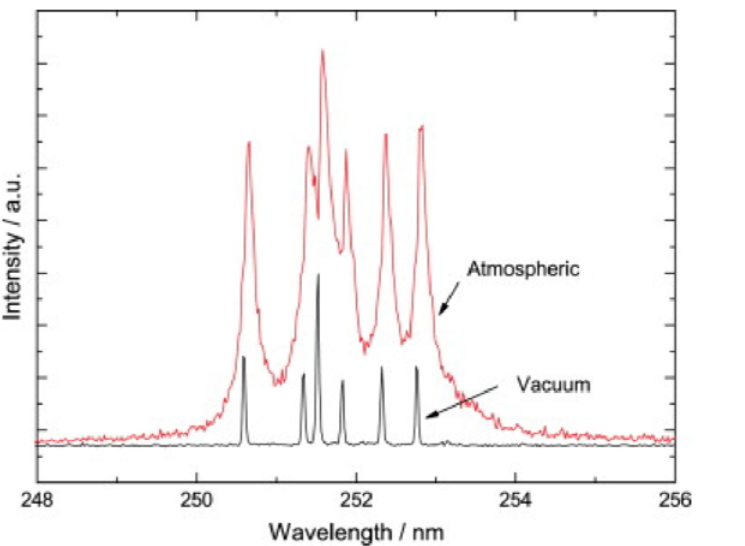
Figure 2. Comparison of LIBS spectra of Si at atmospheric and 10-6 Torr. Reprinted from reference